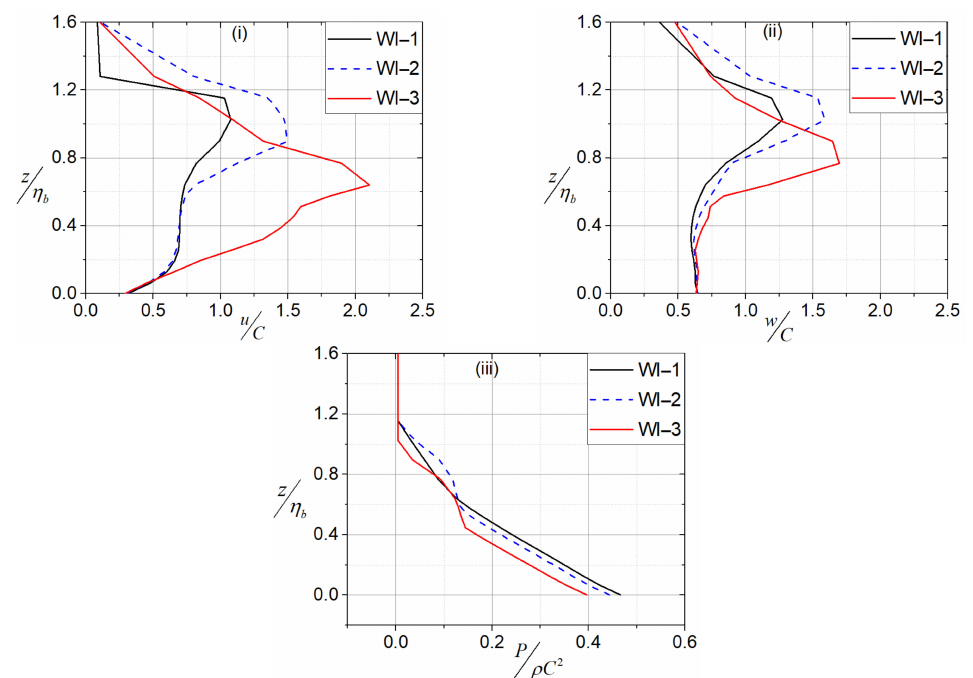
Figure 15. The variation of peak normalised wave parameters in the vertical z-direction ( i ) horizontal velocity ( ii ) vertical velocity and ( iii ) pressure in the vertical z -direction for three wave impact scenarios: WI-1, WI-2 and WI-3 at S/d = 0.